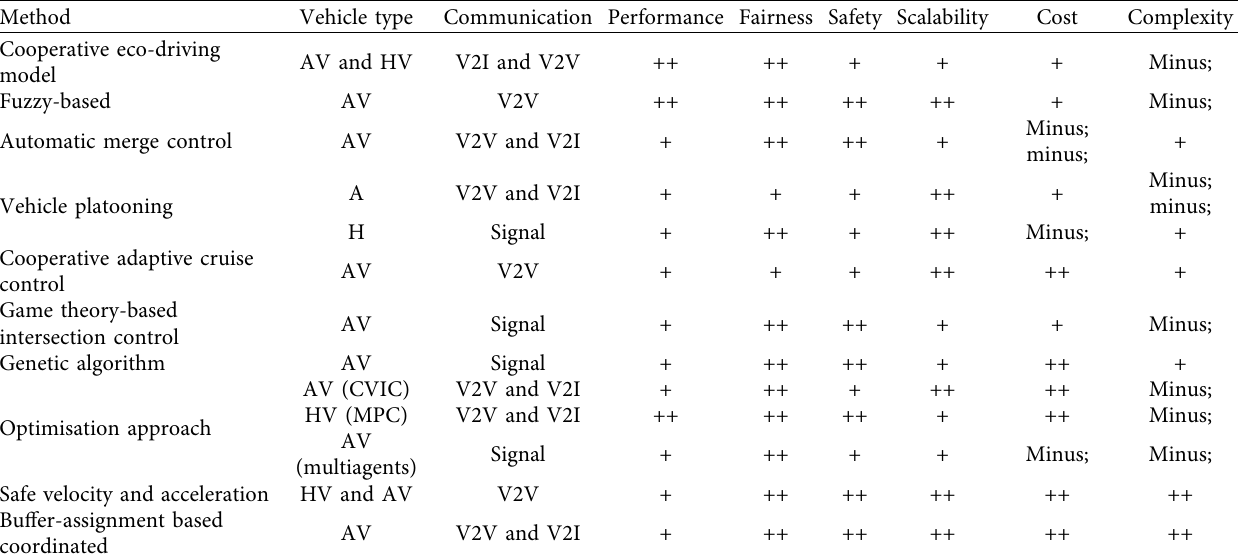
Table 1: Categorisation based on centralised intersection control.